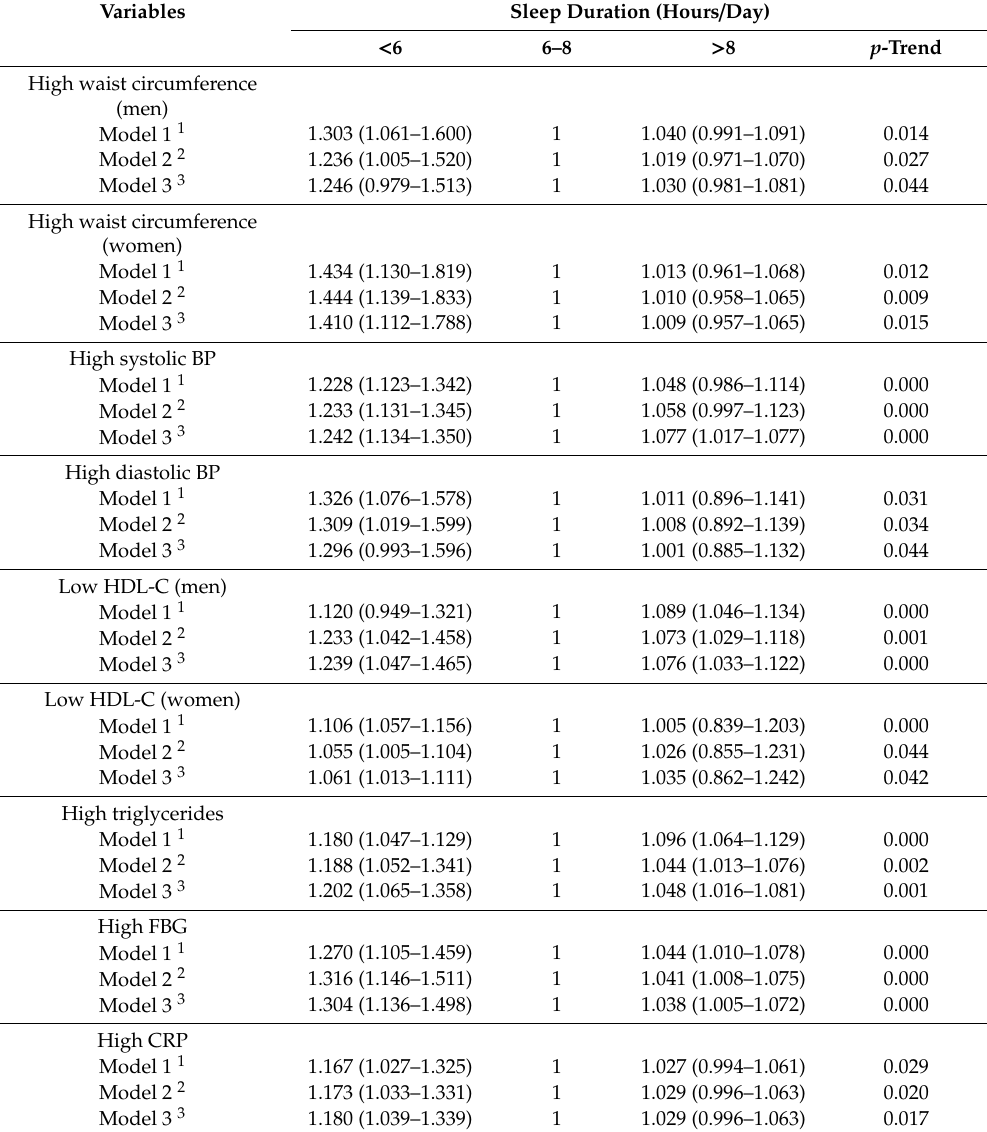
Table 2. Odds ratios (95% CI) of the components of metabolic syndrome and C-reactive protein across sleep